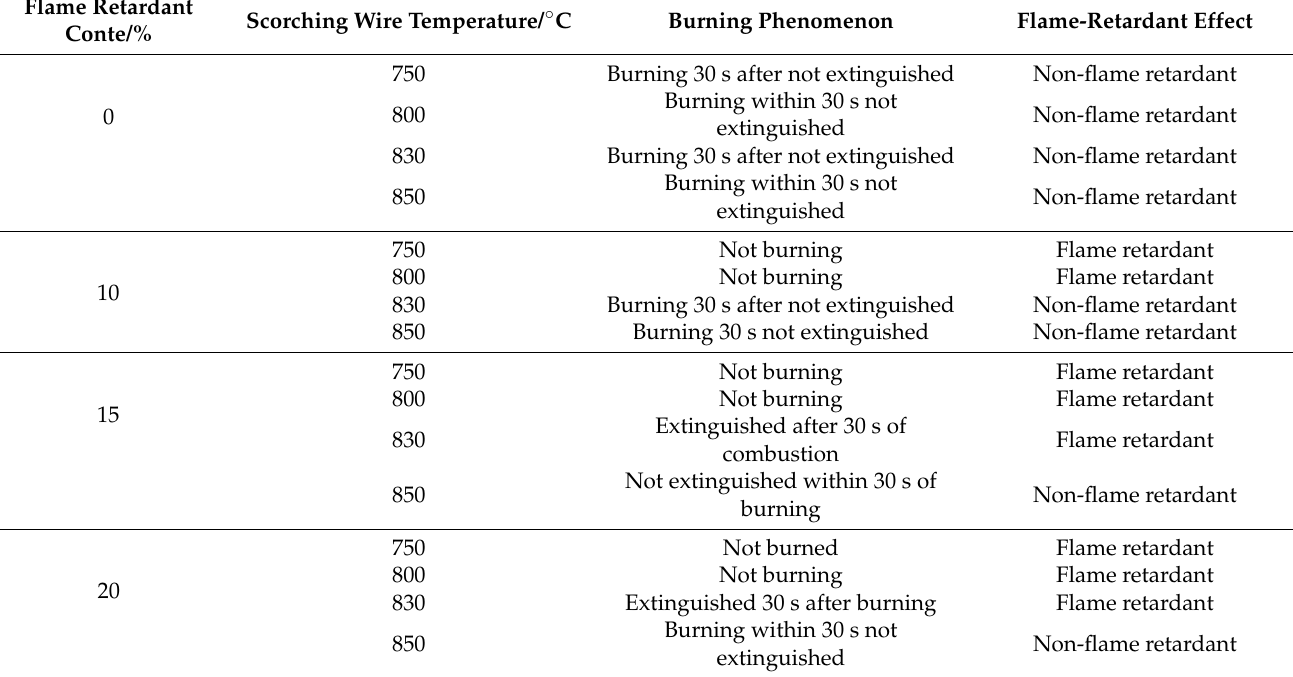
Table 5. Scorching wire tester test